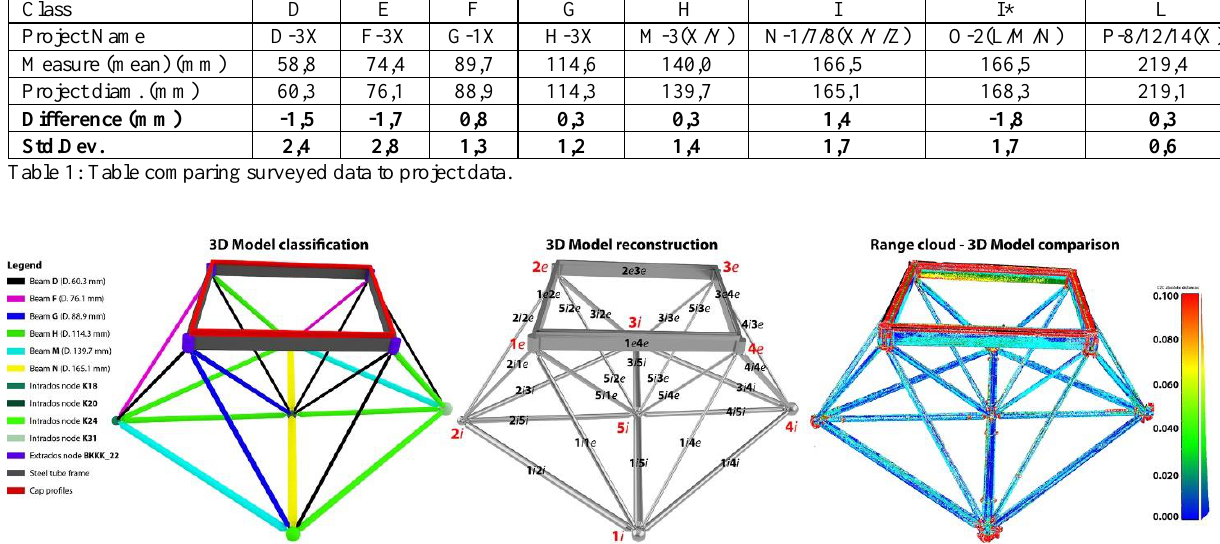
Figure 11: Classification scheme of mesh #127, the 3D model with proposed nomenclature of the elements and comparison between the reconstructed 3D model and the surveyed one